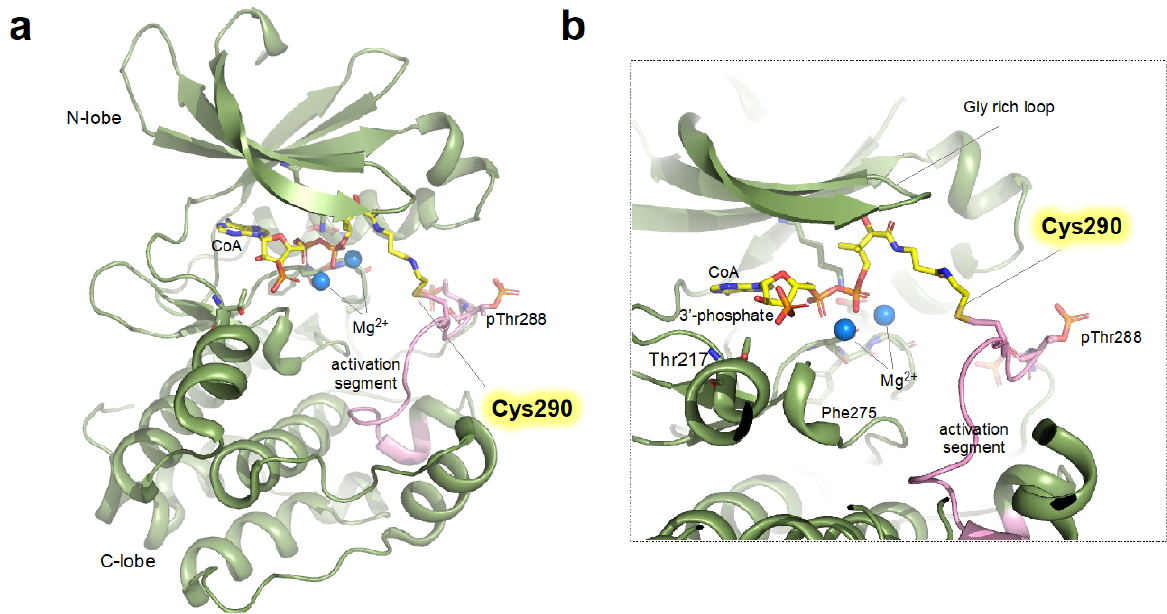
Figure 2. Structure of monomeric CoAlated AURKA structure ( a ) Crystal structure (shown as ribbon representation) of AURKA bound to CoA (PDB ID: 6I2U) displaying monomeric structure (See main text for details). ( b ) Close-up view of the active site (ATP binding pocket) of CoAlated AURKA. Cys290 forming covalent bonds with CoA is shown as yellow stick and activation segment is colored in pink.